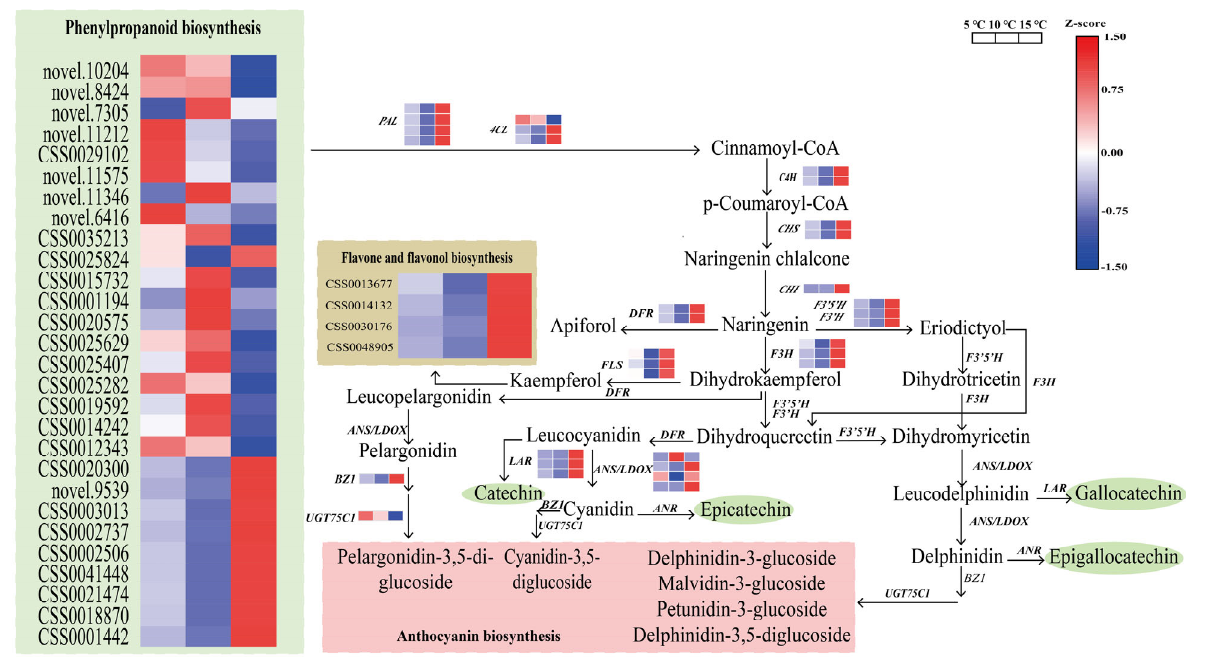
Figure 7. The expression patterns of genes in the flavonoid pathway in the 5 °C, 10 °C, and 15 °C DIF treatments.